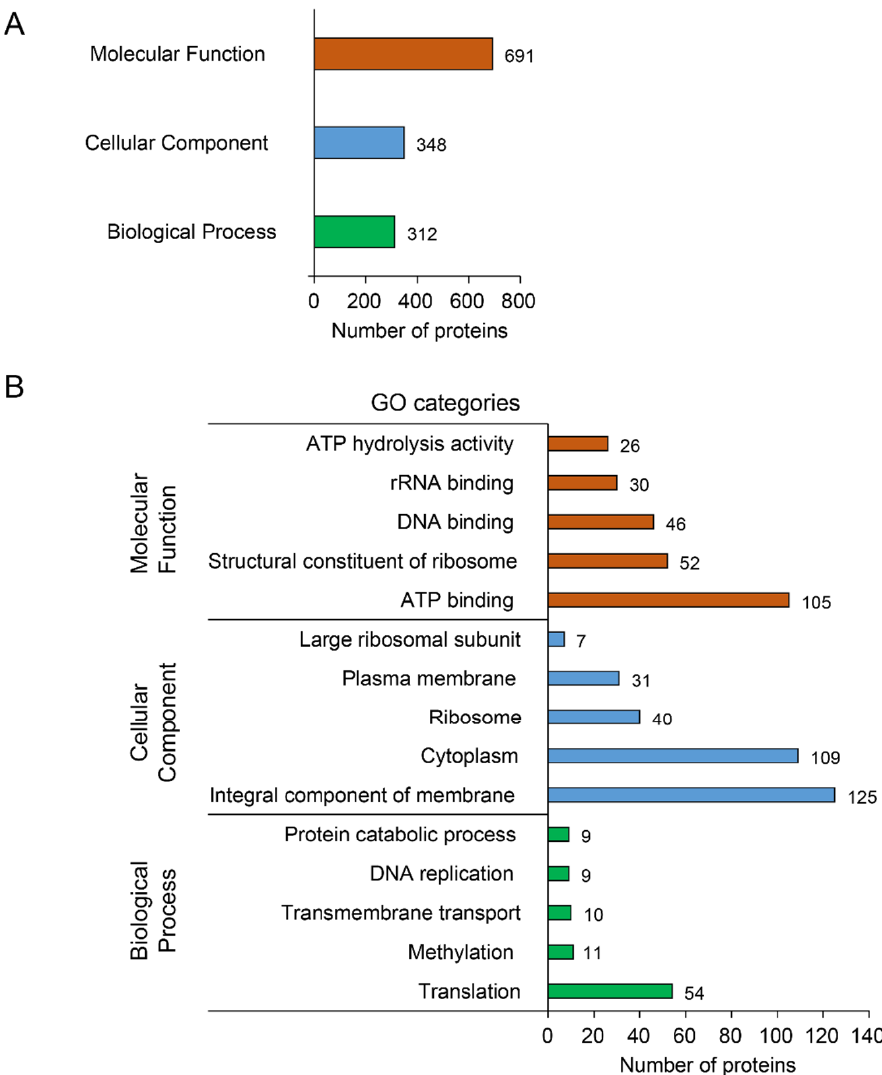
Figure 3. Gene Ontology categories associated with the CDSs from FDp strain CH genome. ( A ) Bar chart showing the distribution among the three main GO domains. One protein can have several molecular functions. ( B ) Bar chart showing the five most represented GO categories in each domain.